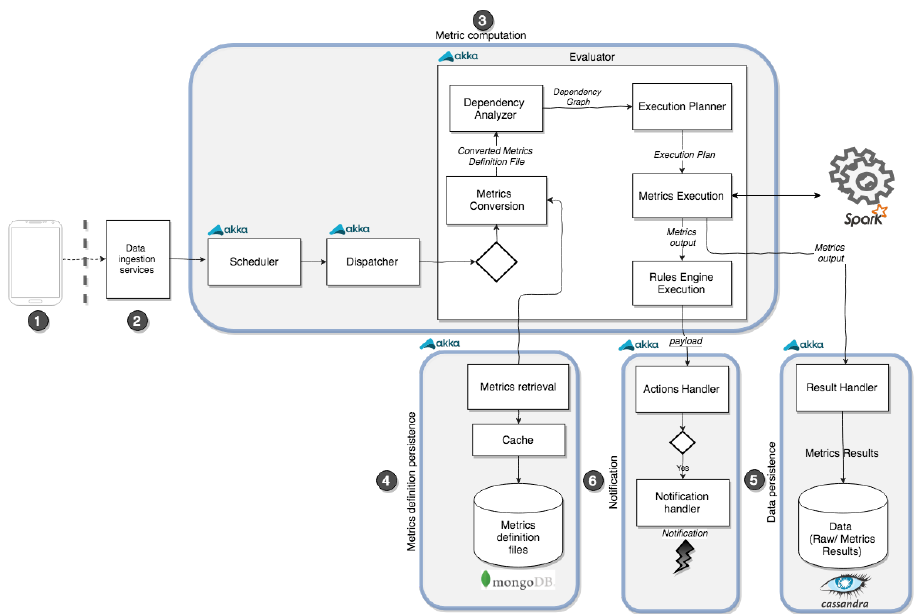
Figure 9. Data flow and involved micro-services in the Metrics computation